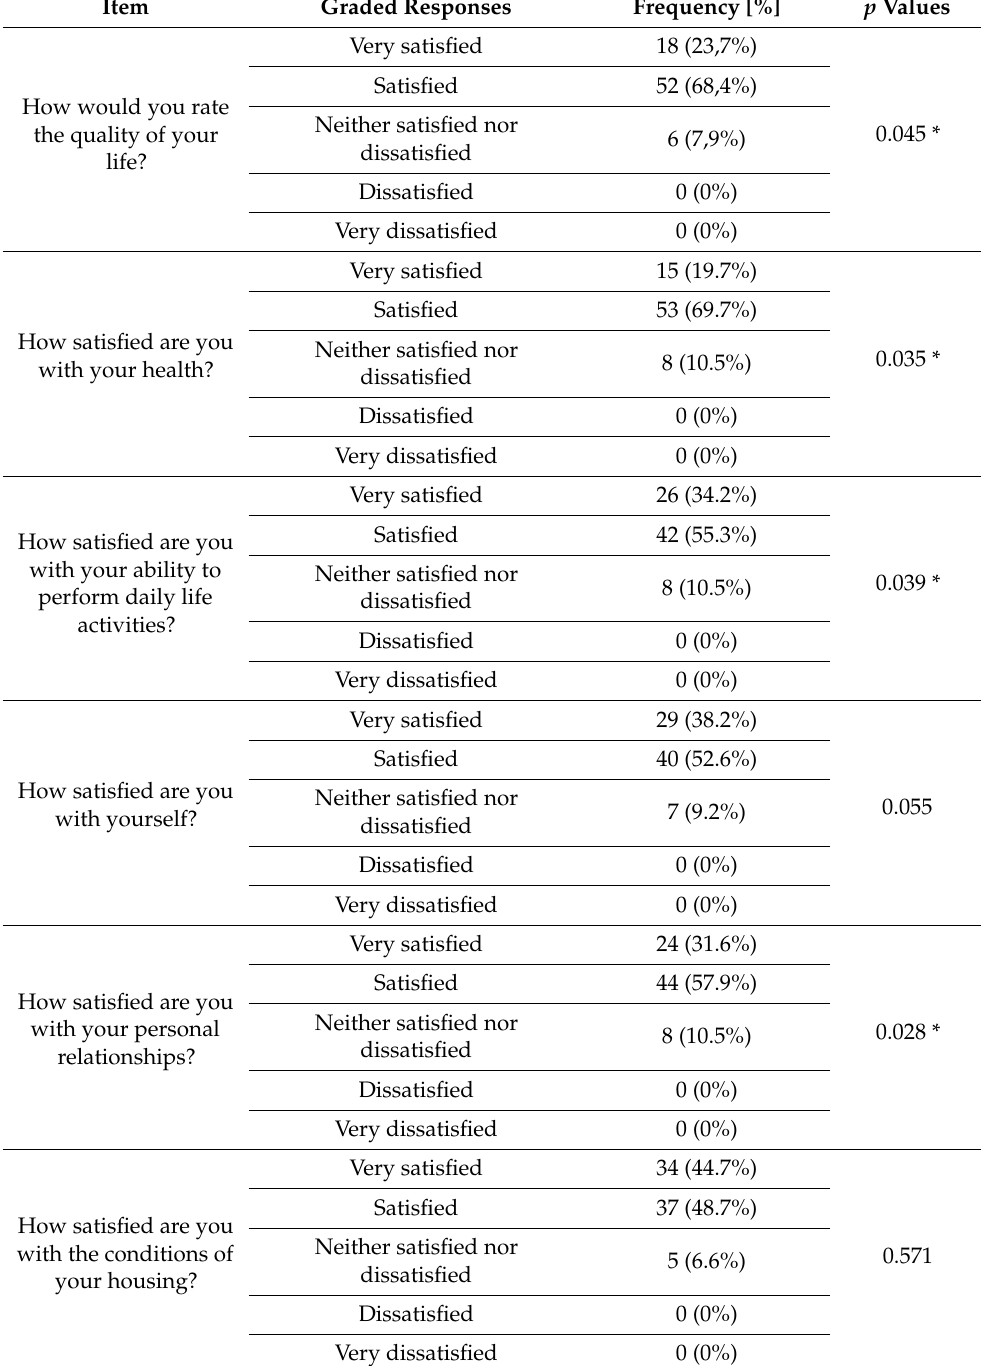
Table 6. Quality of life of participants six months after COVID-19. Results are presented as frequency of responses [%]. Statistical significance was obtained using the Chi-square test (X2). Asterisks (*) represent the statistically significant difference in distribution of responses among study population ( p <